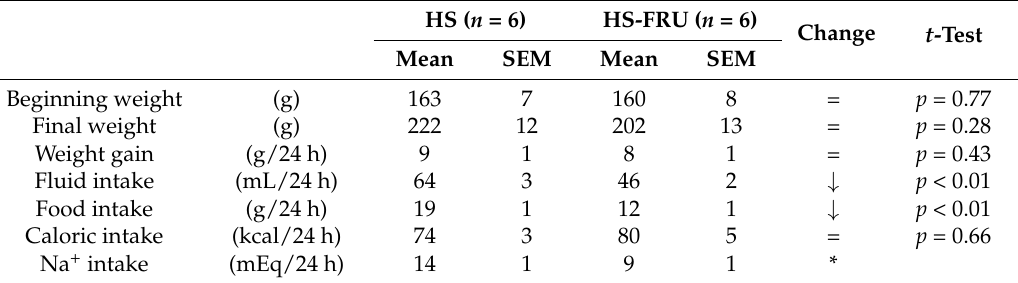
Table 2. Nutritional profile and growth.